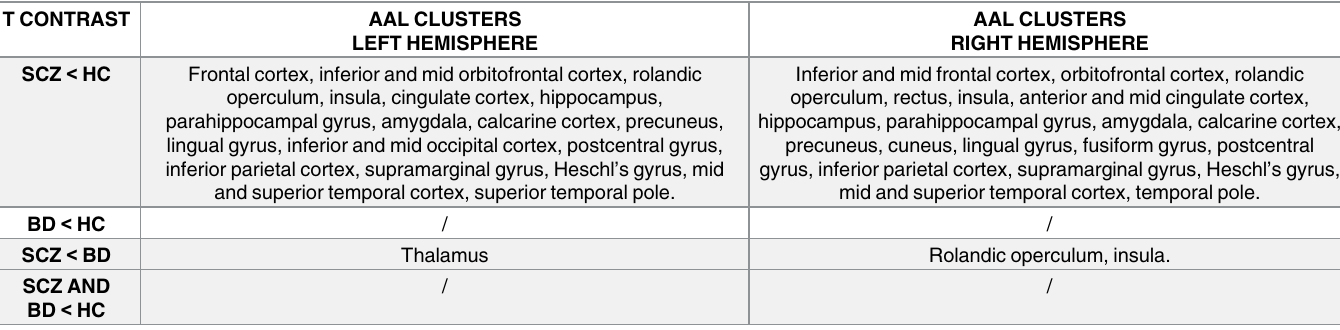
Table 3. Significant AAL regions of the ROI analysis of Dataset1(p < 0.05, Bonferroni corrected). T CONTRAST